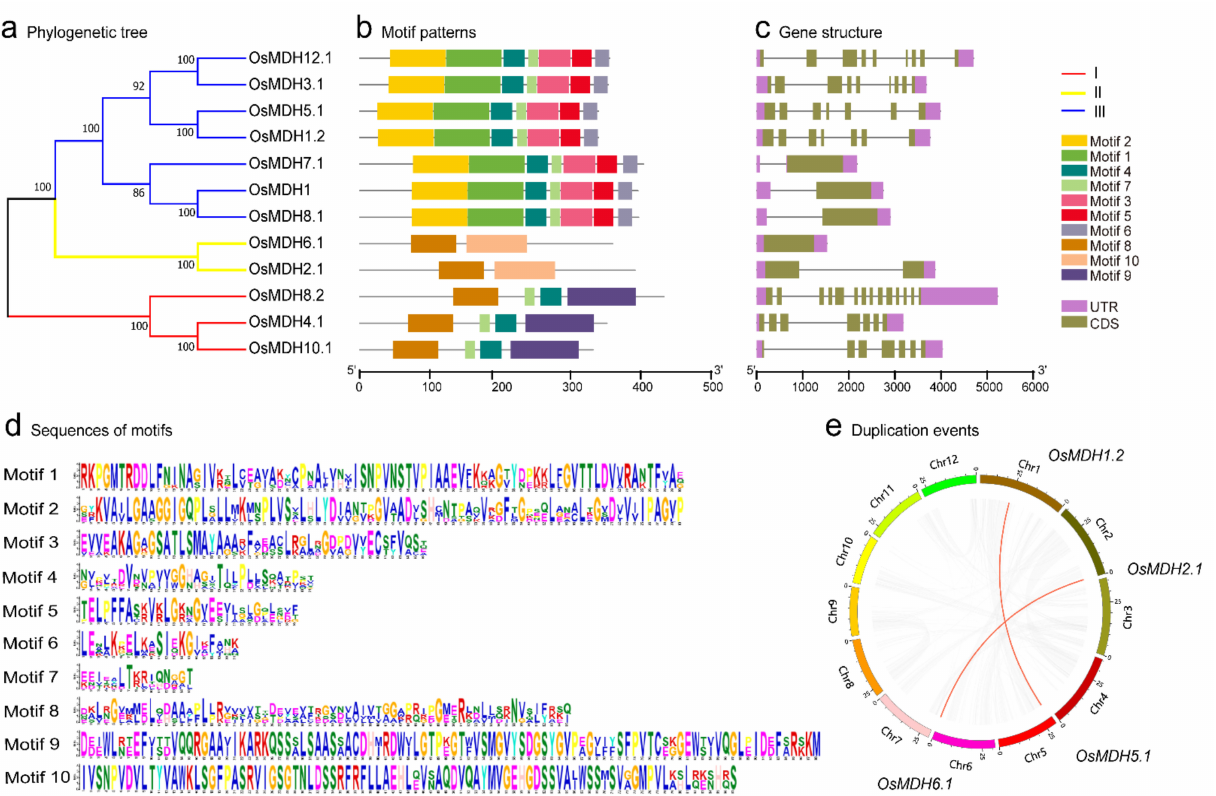
Figure 1. Phylogenetic relationships, gene structures and conserved motif analysis of MDH genes in rice. ( a ) The phylogenetic tree was constructed based on the full-length sequences of rice MDH proteins. ( b ) The distribution of conserved motifs in OsMDH; the ten different colored boxes represent ten different motifs. ( c ) Exon-intron structures of the OsMDHs genes. Green boxes indicate exons; black lines indicate introns, the upstream/downstream area is indicated by a purple box. ( d ) Sequence logo of the MDH proteins motifs. The height of each amino acid represents the relative frequency of the amino acid at that position. ( e ) Segmental duplication events of MDH genes in the Oryza sativa L. The gray curves indicate all the collinearity blocks in the rice genome, and the red curves indicate the segmental duplication events of OsMDH